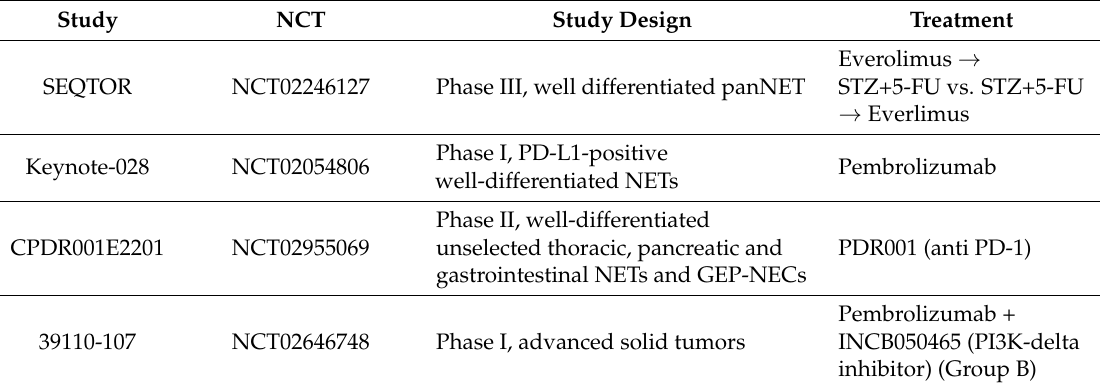
Table 2. Ongoing clinical trials including NET patients reported in the